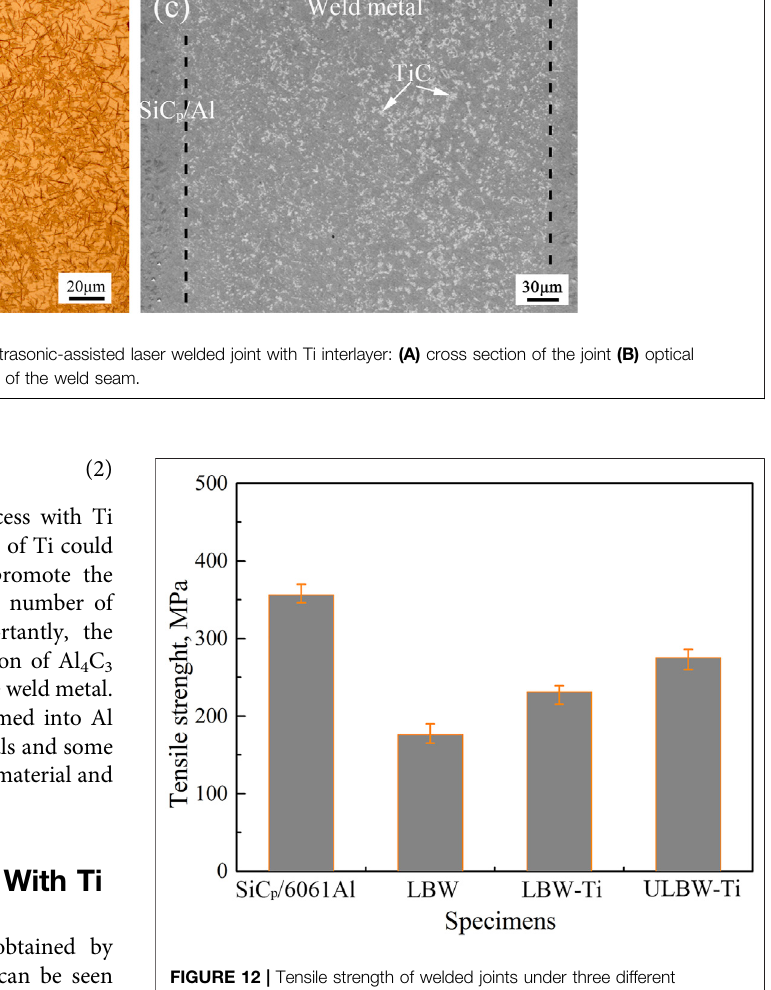
FIGURE 12 | Tensile strength of welded joints under three different